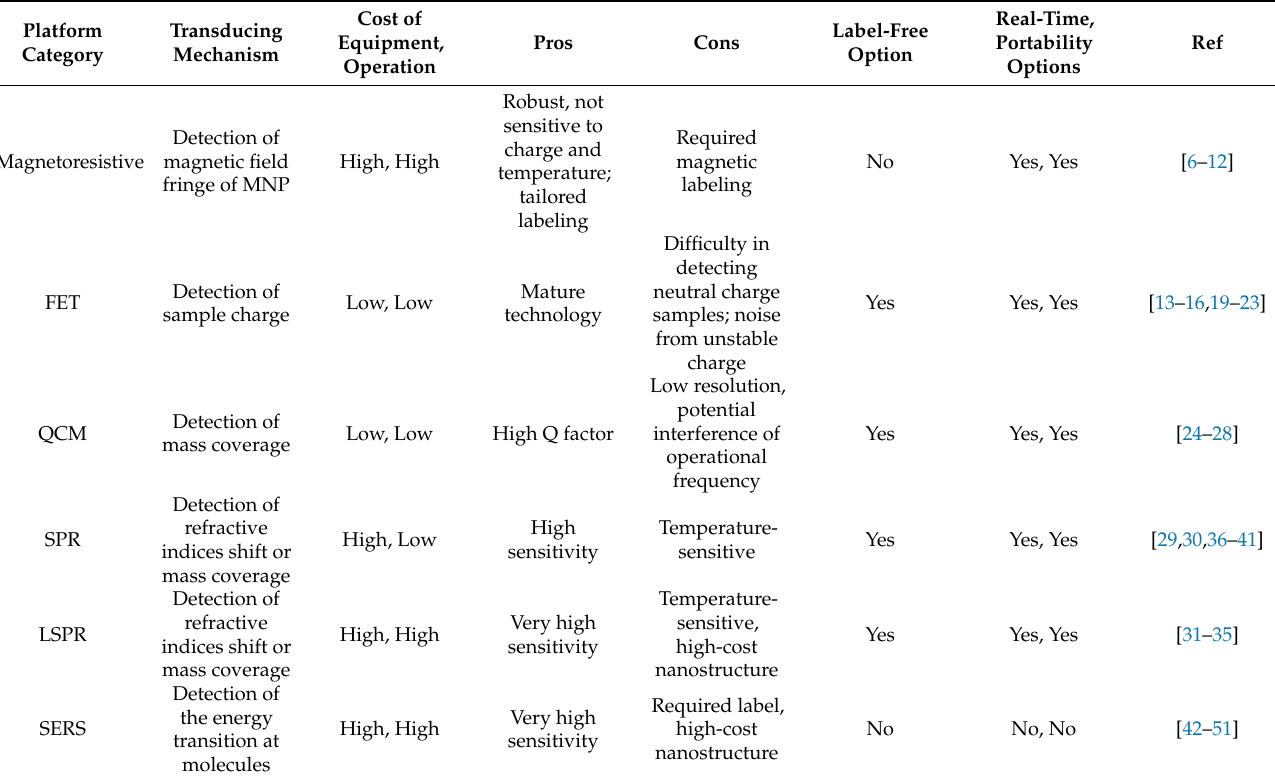
Table 1. Comparison features and characteristics of biosensor platforms.